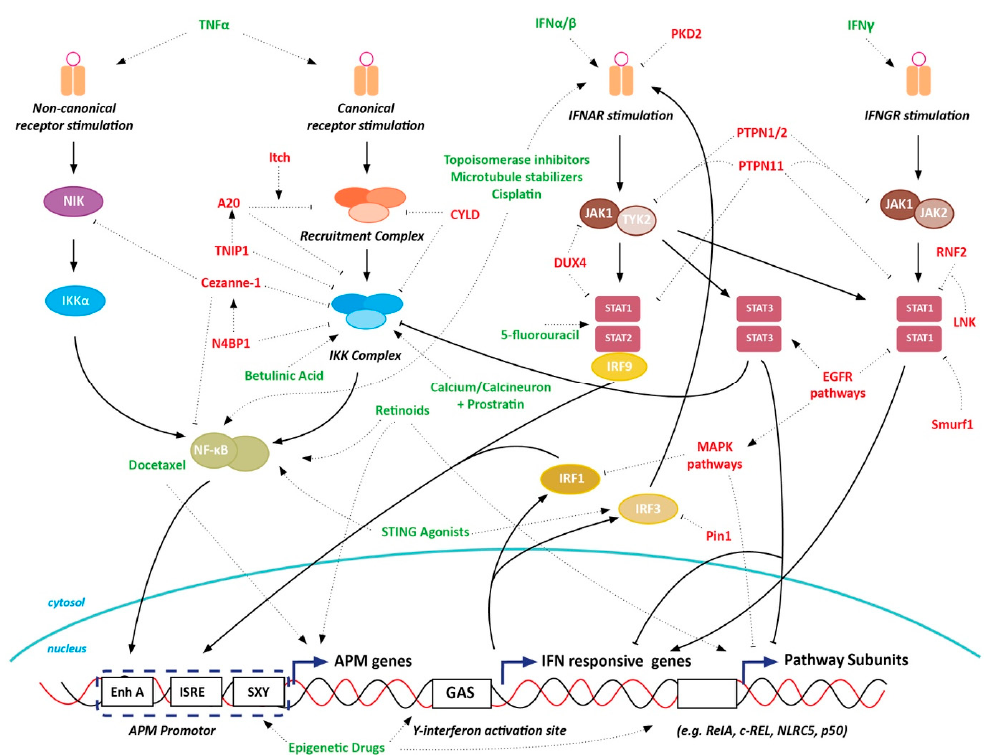
Figure 4. Potential therapeutic interference to boost MHC-I antigen presentation of tumors. Targetable negative pathway regulators are shown in red, (general groups of) compounds positively affecting pathway activation are shown in green.